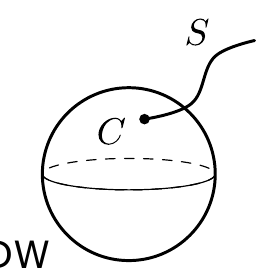
Figure 1 . A time slice of the domain wall with the operator (3.45). The surface S is infinitely long or ended at another quark representing the color-electric flux